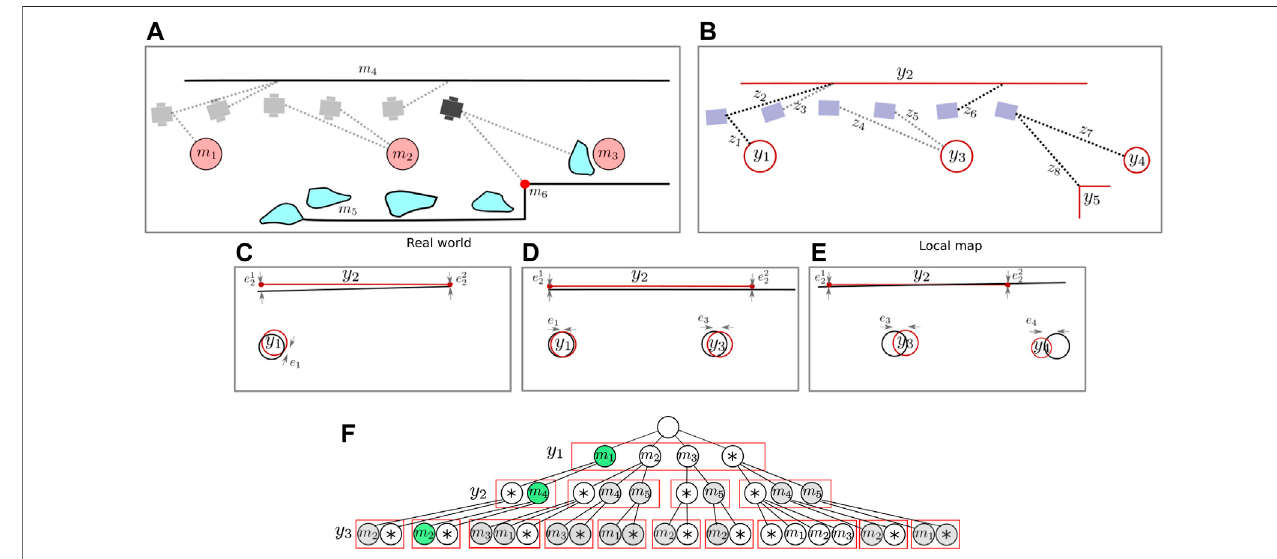
FIGURE 3 | A basic example showing the global association tree. As the robot drives in the real world (A) , it builds a local map of features (B) . The local measurements are associated with these local features, and added to their set. Nodes are then used to represent an association between a local feature and a feature on the global map in (F) . In this example, the robot fi rst spots a circular feature. After spotting it multiple times, the consecutive measurements are added to a set and a local feature is instantiated. Possible pairing hypotheses with the global map are generated based on feature type and dimensions. When a new line segment is detected, a second layer of hypotheses is added to the tree based on spatial consistency between the circle and line feature on the local map and the global map. Finally, an unmapped object is spotted which has similar geometry to a column, highlighting the importance of allowing for a unmapped object option in the association tree, although these levels are not visualized anymore. In sub fi gure (C – E) the spatial congruency is visualized, which is used together with the feature ’ s descriptive component to accept or reject association hypotheses.